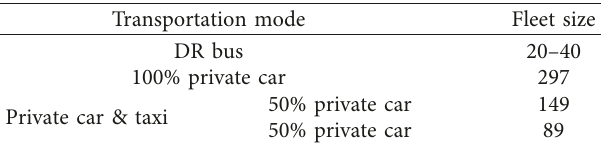
Table 6: Vehicle fleet size of different transportation modes to serve the morning travel